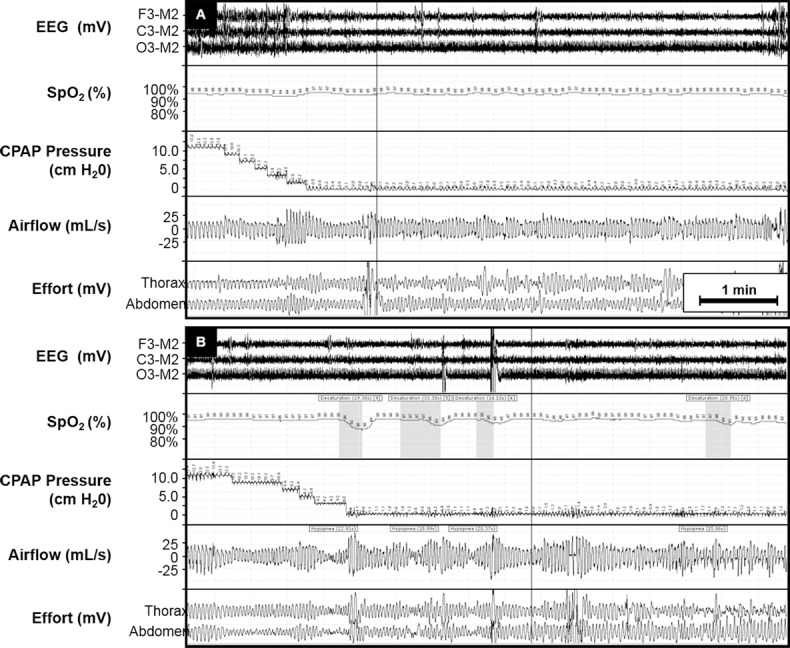
Representative tracing of CPAP depressurization during sleep in a subject with previous diagnosis of severe OSA.An approximately 7 minute period is depicted. (A) Rapid reduction in nasal pressure did not lead elicit significant obstructive events. In the same subject, a different period of CPAP depressurization (B) induced hypopneas.